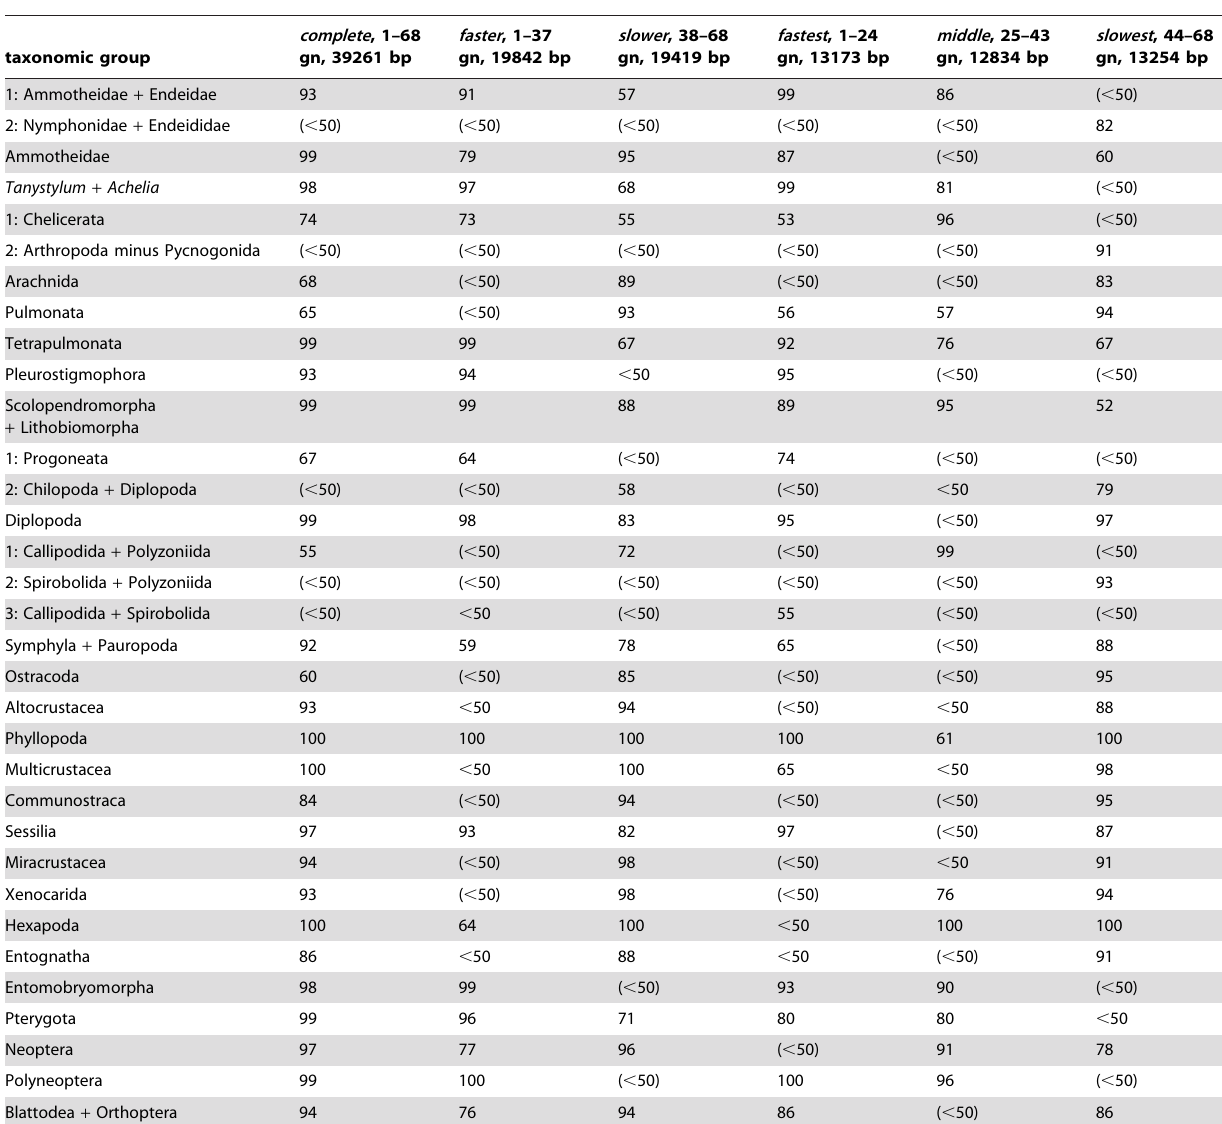
Table 3. Bootstrap values for selected taxa that are sensitive to nonsynonymous rate properties of the data matrix. a